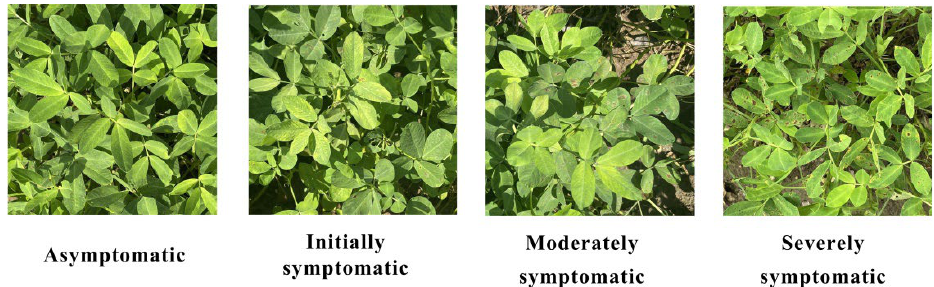
Figure 3. Canopy images with different disease severity levels at the plant scale.